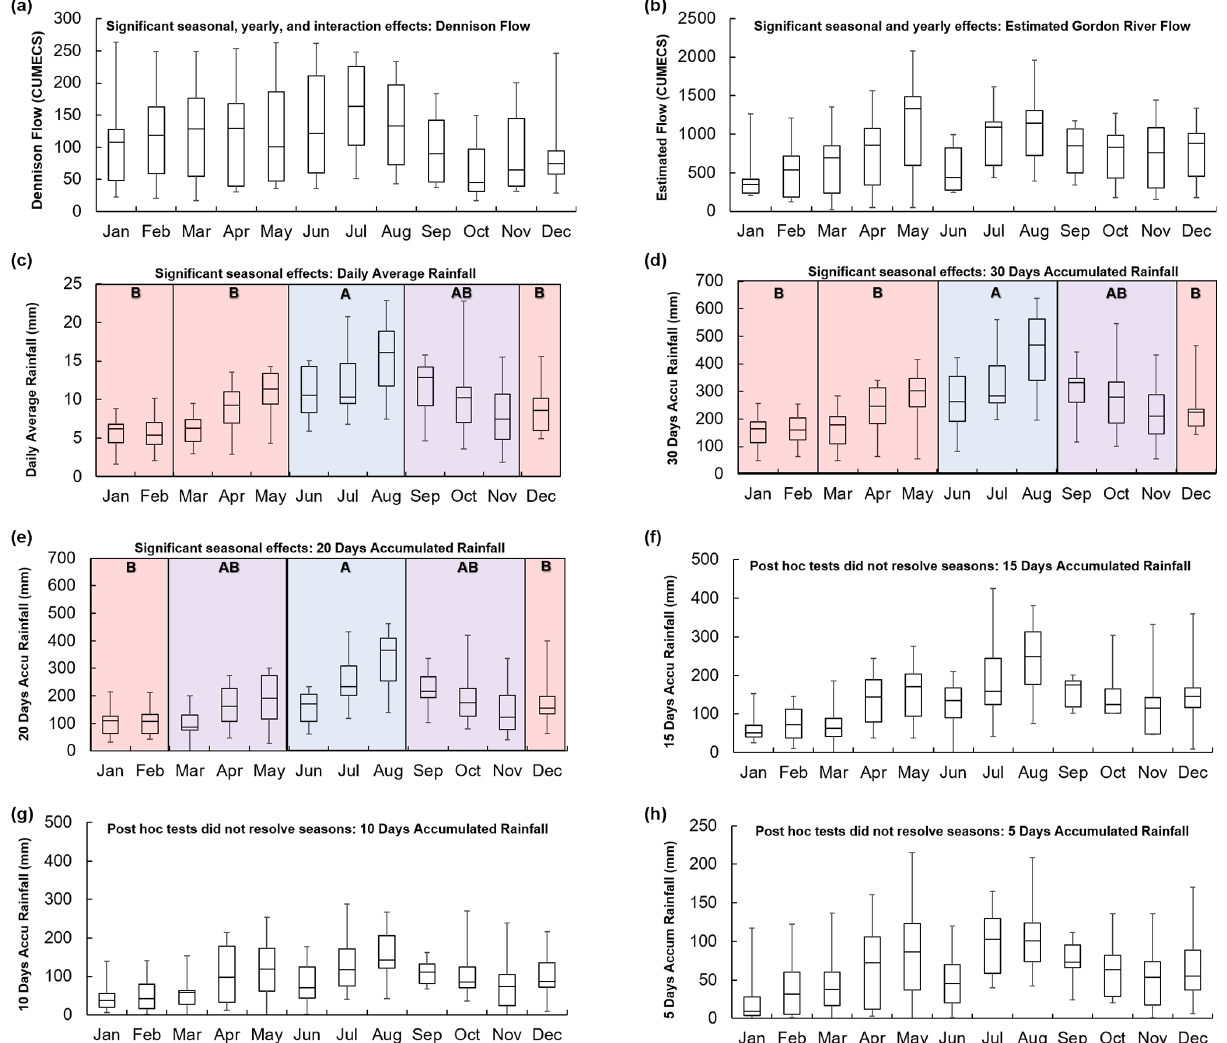
Figure 2. Box plots of flow and rainfall metrics from 2011 to 2021 including (a) Gordon River Stream Gauge flow, (b) estimated daily flow into the harbour, (c) daily average rainfall at Strathgordon station, and (d) 30d, (e) 20d, (f) 15d, (g) 10d, and (h) 5d rainfall accumulation before monthly water quality sampling. Post hoc (Tukey’s HSD) groupings are depicted as colours and letters within the plot area for datasets where two-way ANOVA revealed a significant seasonal effect (for instance Group A and blue shading indicate a significantly distinct group).